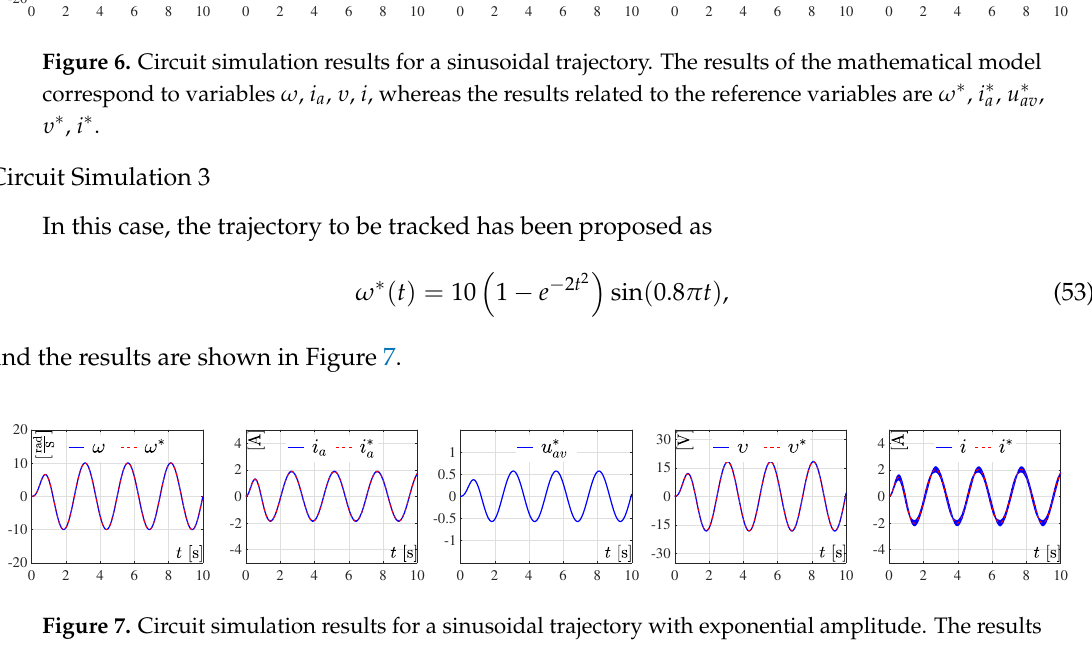
Figure 7. Circuit simulation results for a sinusoidal trajectory with exponential amplitude. The results associated with the mathematical model are ω , i a , υ , i , and the results of the reference variables correspond to ω ∗ , i ∗ a , u ∗ av , υ ∗ , i ∗